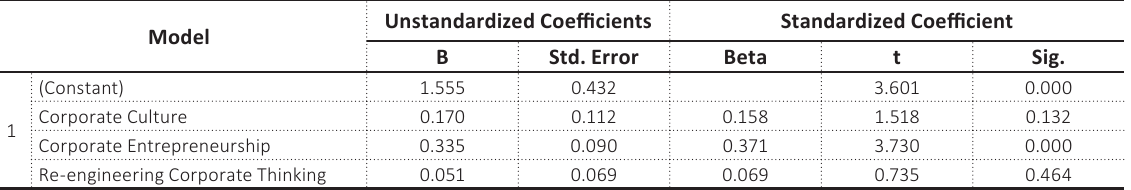
Table 7. Regressing intrapreneurship sub-variables on the volume of production